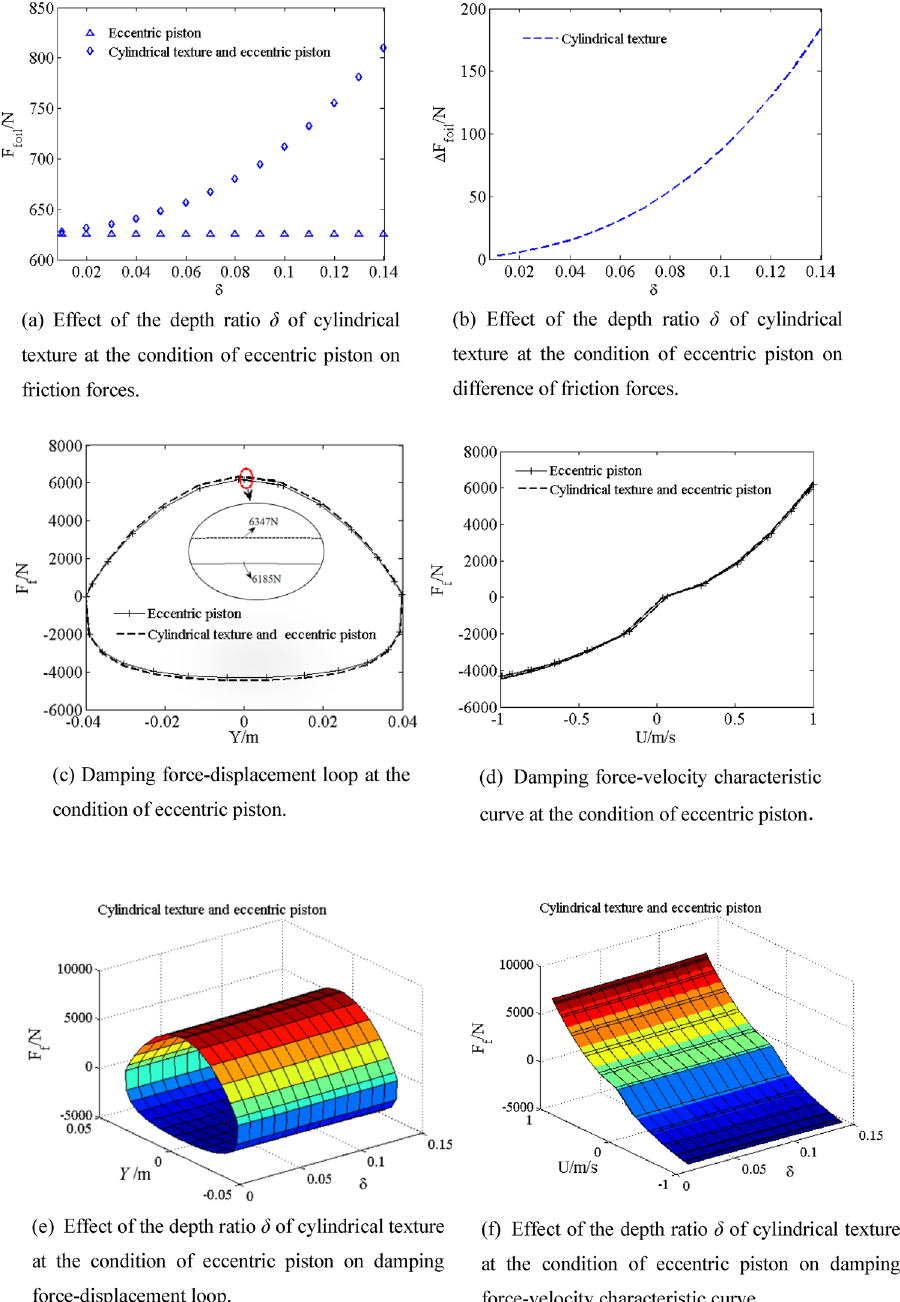
Figure 10. Effect of the depth ratio δ of cylindrical texture at the condition of eccentric piston on damping with friction force F foil of eccentric piston (625.8 N), when area ratios S p is increased to 0.18, the friction force F foil of the cylindrical textured eccentric piston (766.4 N) greatly increases by 22.47%. Thus, the cylindrical textured at eccentric piston condition has great effects on friction force. When piston is inclined and eccentric, the friction force F foil of the inclined and eccentric piston and the cylindrical textured inclined and eccentric piston are shown by simulating with different area ratios S p from 0.0003 to 0.18 in Fig. 13e, the difference Δ F foil of friction force of the cylindrical texture inclined and eccentric piston and inclined and eccentric piston is shown in Fig. 13f. The friction force F foil of the cylindrical texture inclined and eccentric piston increases with increasing area ratios S p from 0.0003 to 0.18. F foil - S p curves are approximately linear. Compared with friction force F foil of inclined and eccentric piston (930.3 N), when area ratios S p is increased to 0.18, the friction force F foil of the cylindrical